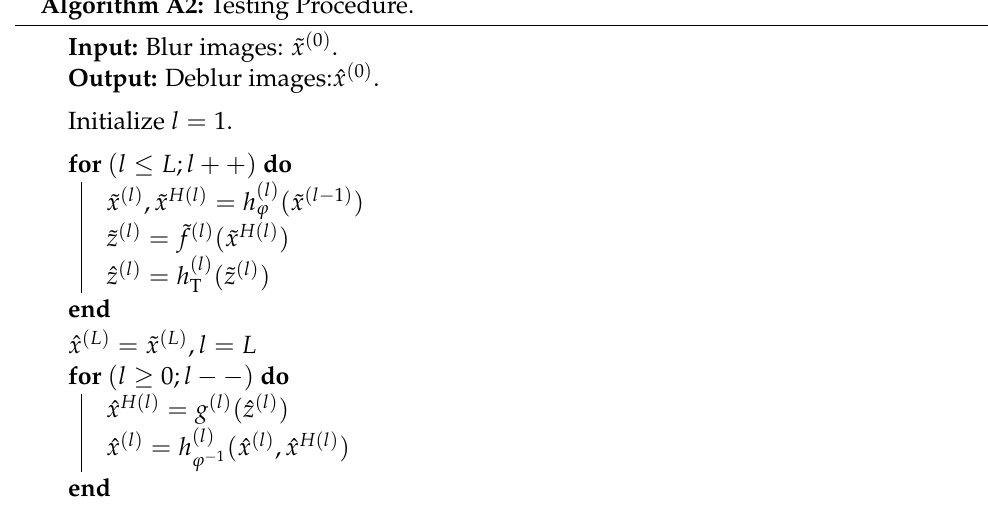
Algorithm A2: Testing